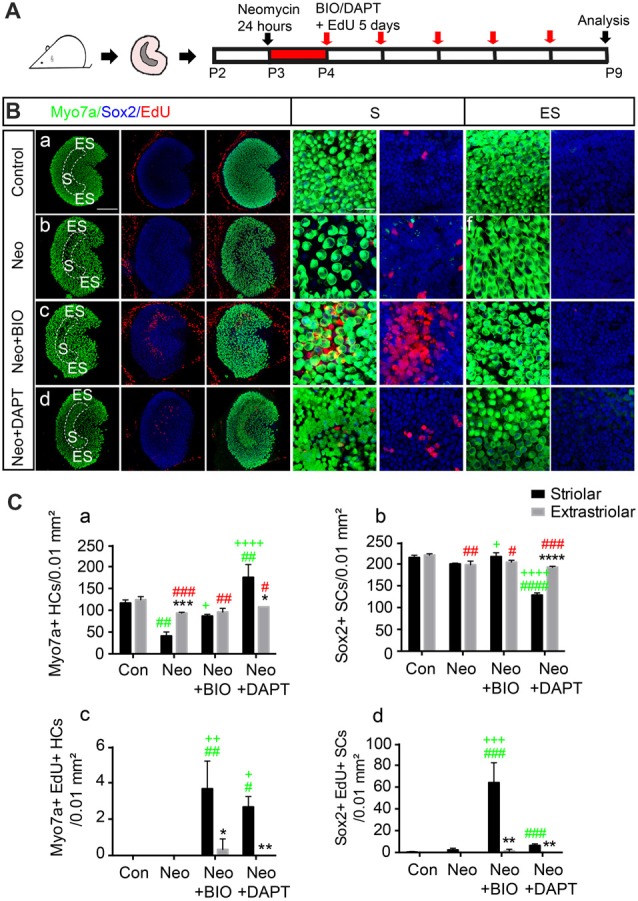
Subset of SCs in the striolar and extrastriolar region in response to Wnt and Notch signaling in vitro. (A) Schematic of the experimental procedure. (B) Utricles from control (a), neomycin (b), neomycin+6-Bromoindirubin-3′-oxime (BIO; c), and neomycin+N-[N-(3,5-difluorophenacetyl)-l-alanyl]-S-phenylglycine t-butyl ester (DAPT; d) groups were dissected and cultured. 5′-ethynyl-2′-deoxyuridine (EdU) was used to label the proliferating cells. All images are low-magnification images showing cultured utricles in the different treatment groups. High-magnification slices show the HC nuclear layer and SC nuclear layer of both the striolar and extrastriolar regions. (C) Quantification of Myosin7a+, Sox2+ and EdU+ cells in the striolar and extrastriolar regions in each group (Ca–d). Data are shown as the mean ± SD. *p < 0.05, **p < 0.01, ***p < 0.001, ****p < 0.0001 (Striolar vs. Extrastriolar). #(Green) p < 0.05, ##p < 0.01, ###p < 0.001, ####p < 0.0001 (Neo, Neo+BIO, Neo+DAPT vs. Con in Striolar). +p < 0.05, ++p < 0.01, +++p < 0.001, ++++p < 0.0001 (Neo+BIO, Neo+DAPT vs. Neo in Striolar). #(Red) p < 0.05, ##p < 0.01, ###p < 0.001, ####p < 0.0001 (Neo, Neo+BIO, Neo+DAPT vs. Con in Extrastriolar). In (B), n = 3. Scale bars are 100 μm in the low-magnification images and 20 μm in the high-magnification images in (B).